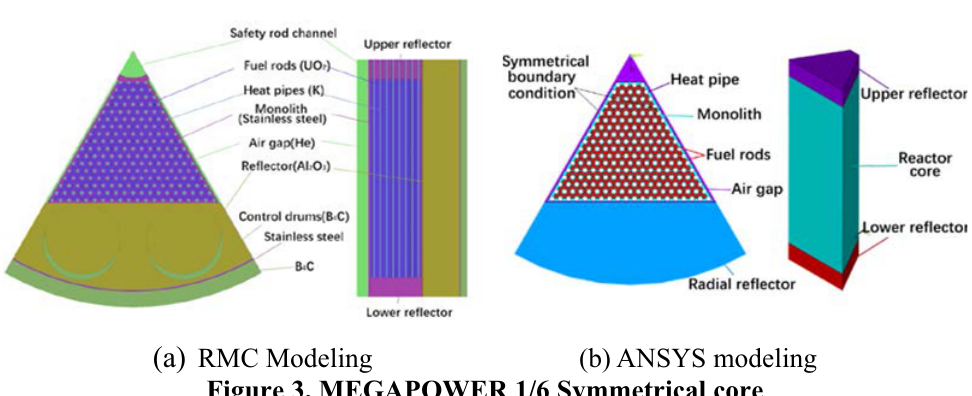
Figure 3. MEGAPOWER 1/6 Symmetrical